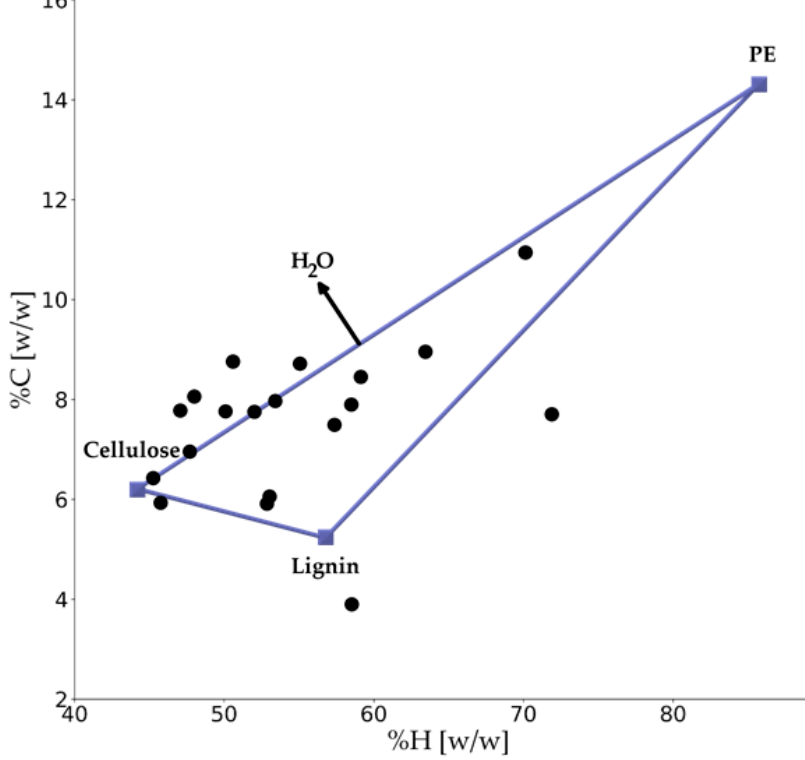
Figure 9. Typical compositions of different RDF in terms of C and H (wt% ash-free) (Redrawn from [125]). Black circles represent different data points. Reprinted from Computers and Chemical